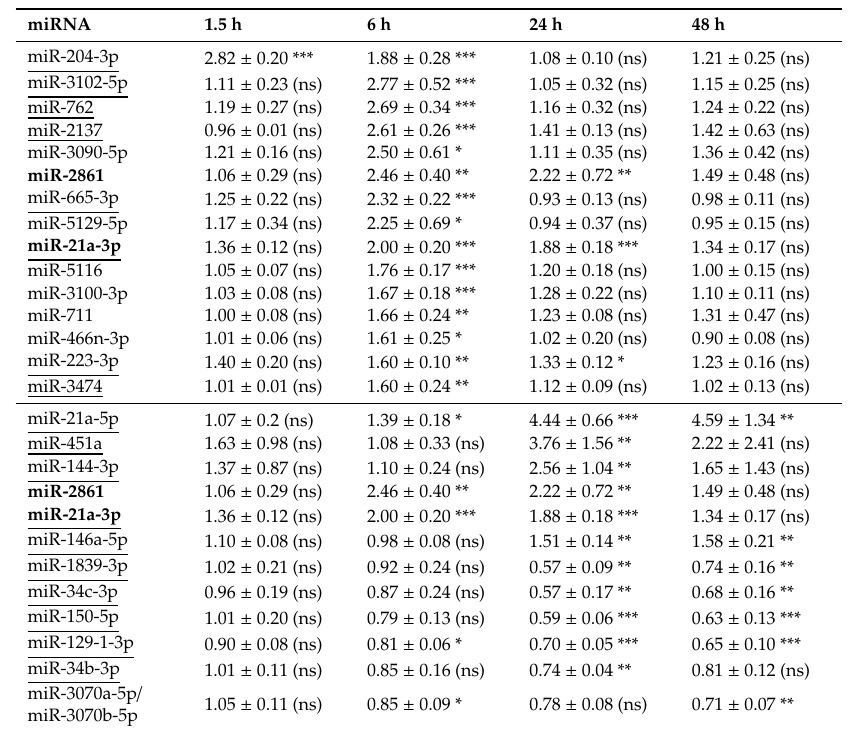
Table 2. Fold changes in miRNAs di ff erentially